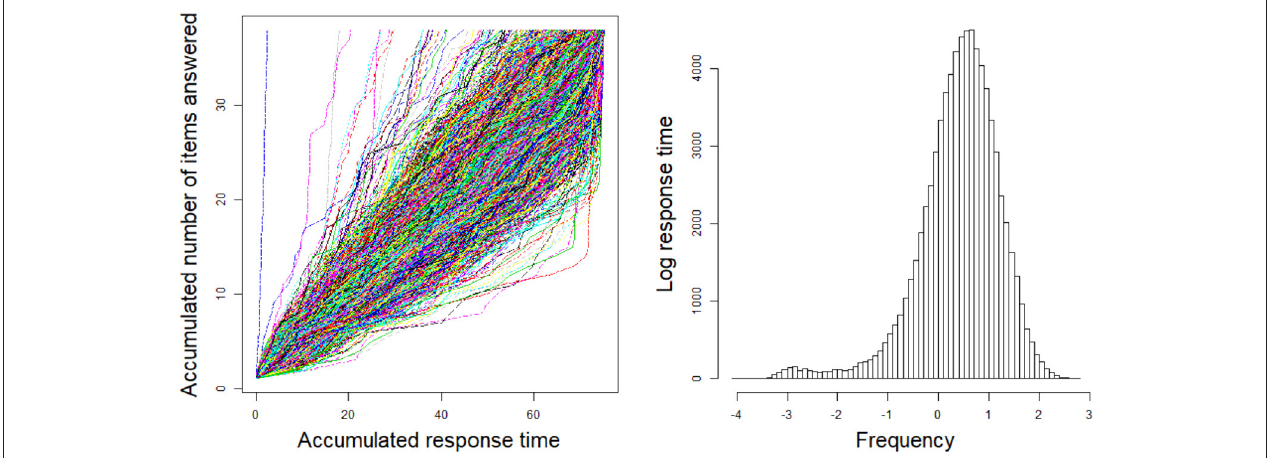
FIGURE 7 | The response time path for the examinees and the histogram of response times obtained from all item-person combinations.